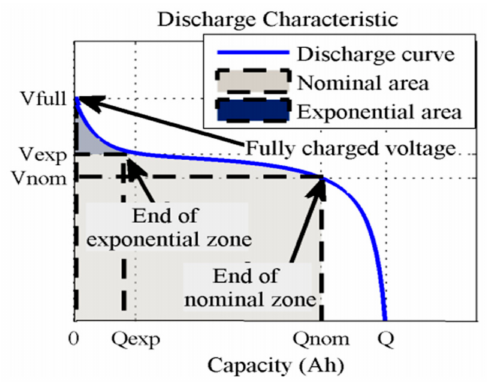
Figure 3. Voltage response in